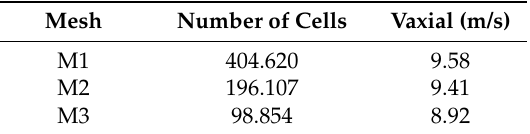
Table 6. Axial velocity values in the chosen point for each mesh level.